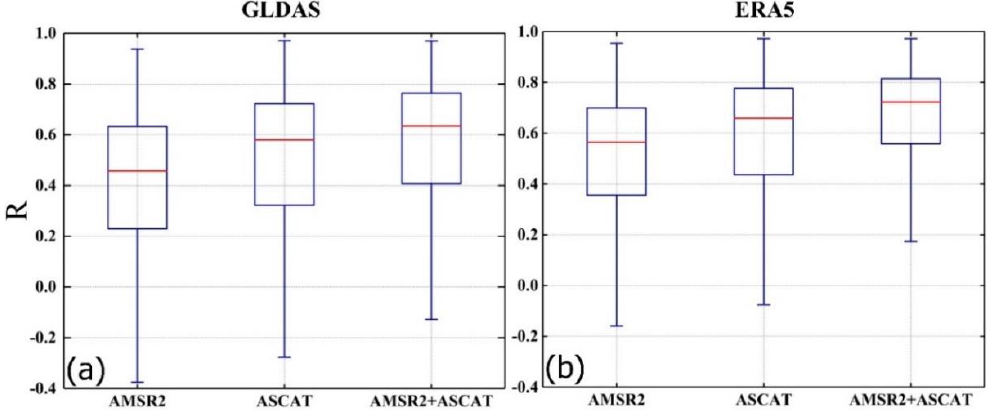
Figure 12. Box plots of correlation coefficients of merged (AMSR2+ASCAT) and parent (AMSR2 and